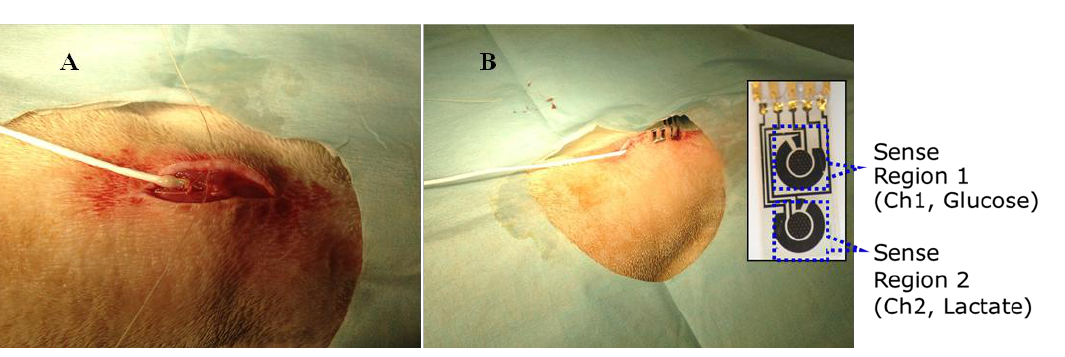
Figure 8. Sprague-Dawley rat under anaesthesia with, ( A ) the MDEA 5037 biotransducer implanted into trapezius muscle and secured into place with a suture, and ( B ) the incision closed and secured around the MDEA 5037 with surgical